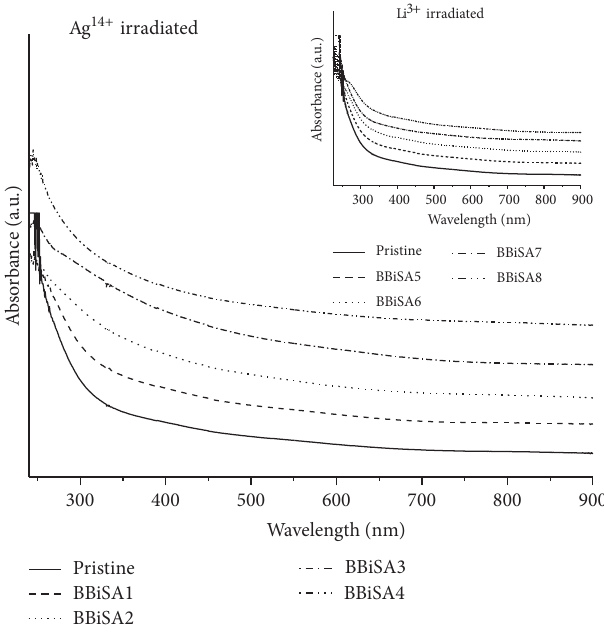
F 5: Showing the UV-Vis spectra of BBiSA-series glass thin �lm samples before and aer irradiation with Ag spectra of the same glass samples irradiated with Li